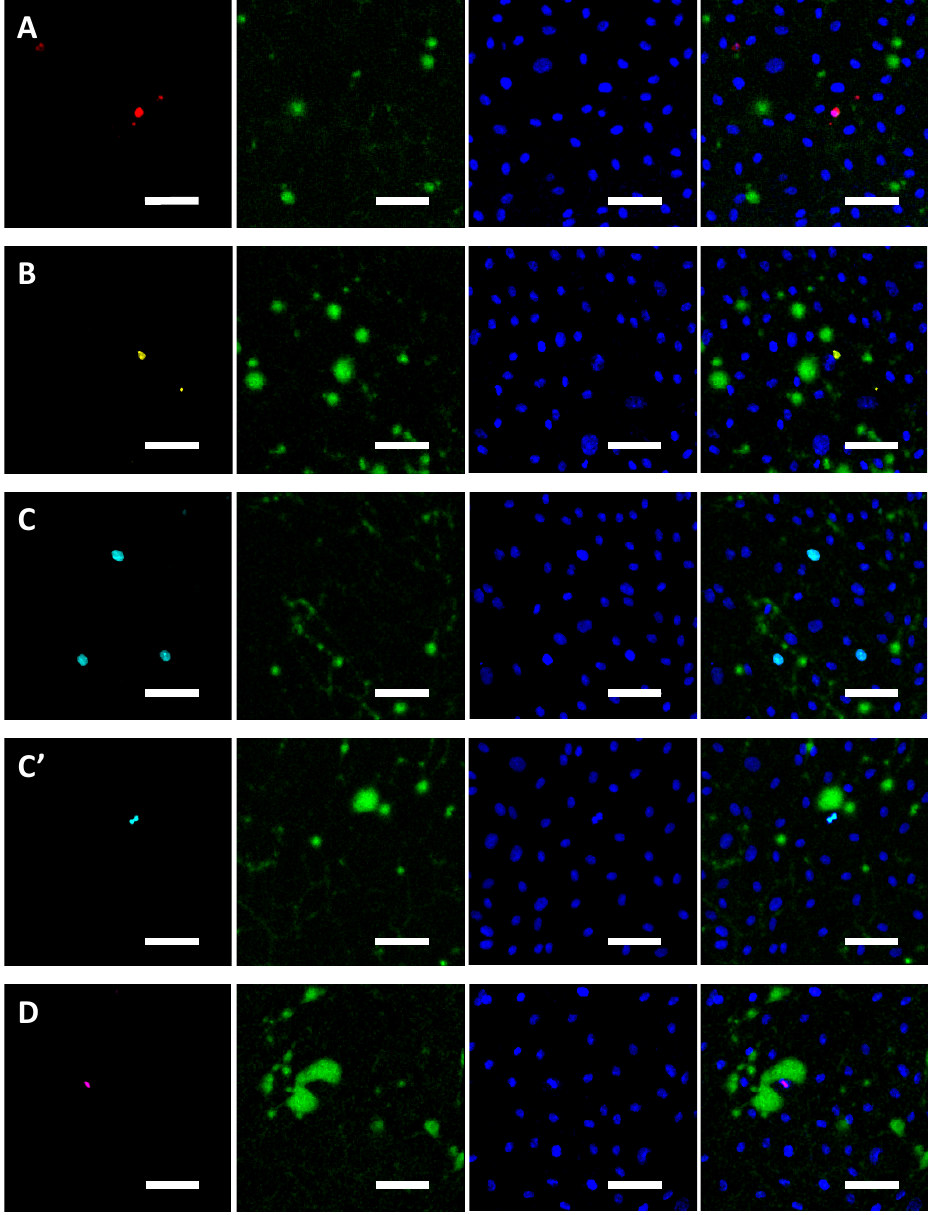
Figure 4. Representative confocal images of endothelial cells. The first column shows staining for ( A ) early-stage apoptosis (red), ( B ) late-stage apoptosis (yellow), ( C ) proliferation, ( C’ ) a proliferating cell that is dividing (turquoise) and ( D ) mitosis (purple). The second and third columns show FITC-avidin accumulation (green) and nuclei (blue) for the same field of view. The last column shows the overlay of all three channels. Bar = 50 μ m.